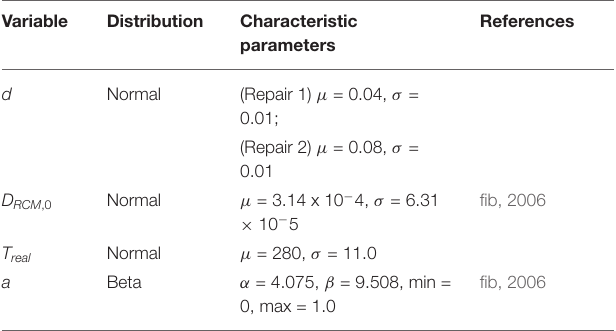
TABLE 2 | Service life modeling parameters specific to the OFU Gimsøystraumen Bridge repair case study.